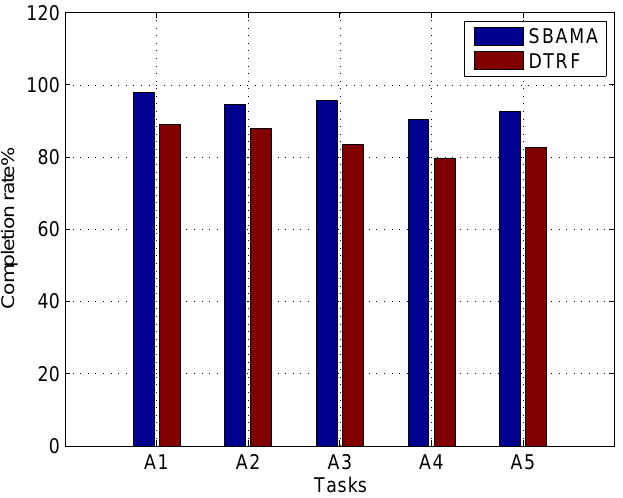
Figure 10. Comparison of task completion rates for different